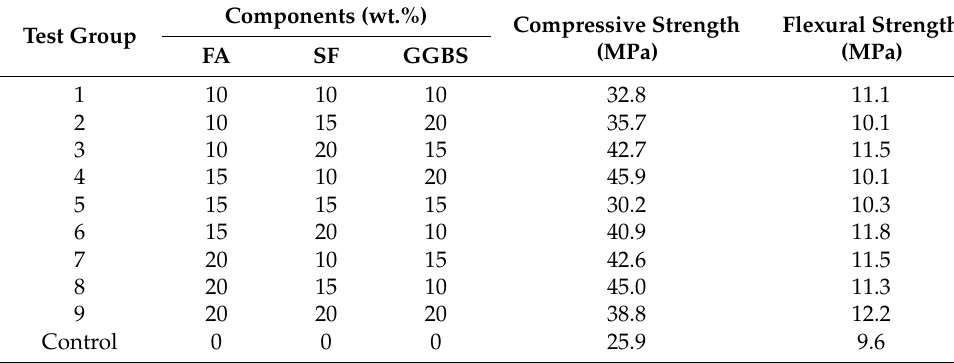
Table 6. Summary of mechanical performance test and calculation results. Test